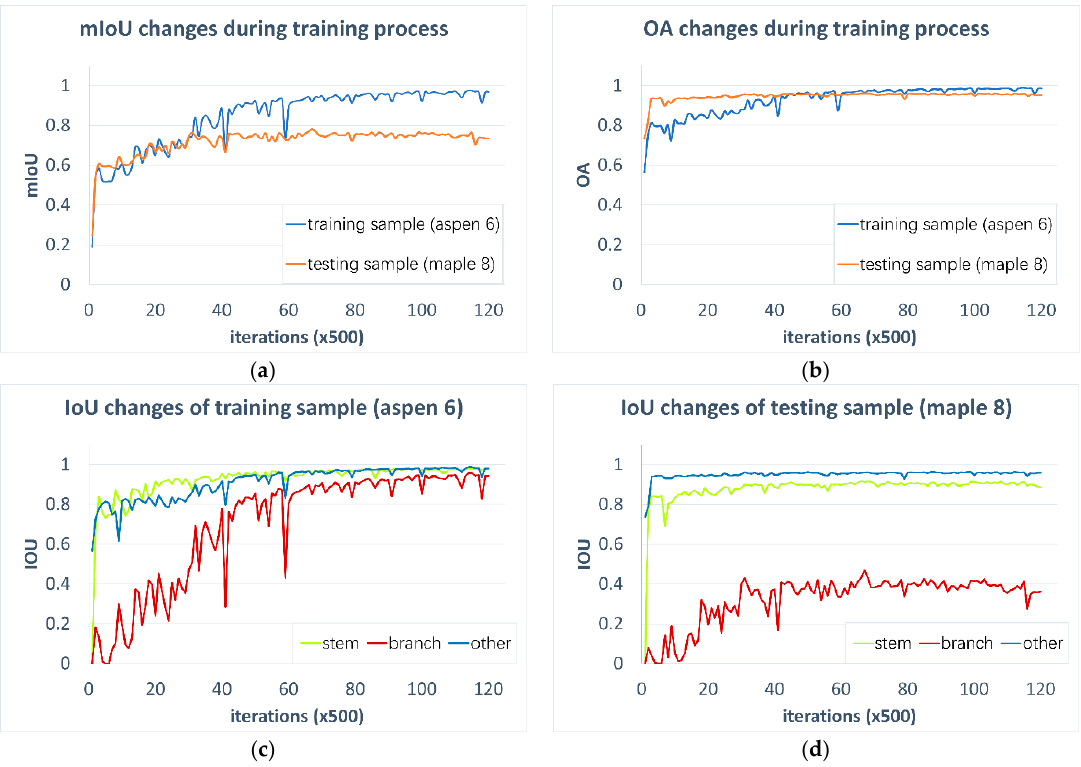
Figure 7. Relationship between accuracy changes and training iterations, for ‘aspen 6’ from training dataset and ‘maple 8’ from testing dataset: ( a , b ) fluctuation of mIoU and OA; ( c , d ) fluctuation of stem IoU, branch IoU, and other components’ IoU.